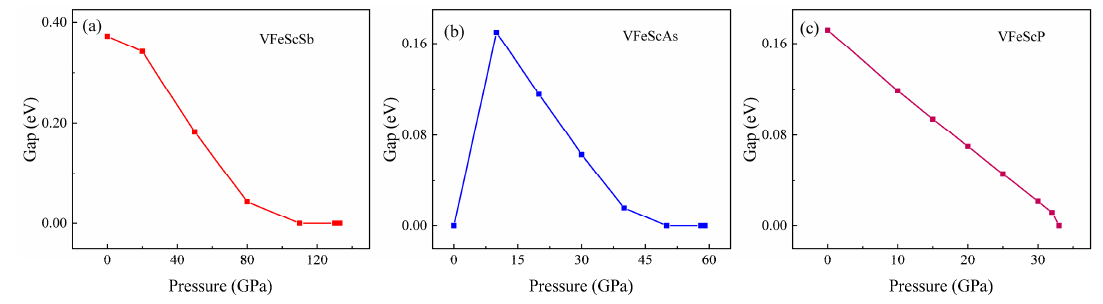
Figure 9. Band gap of type-I ( a ) VFeScSb, ( b ) VFeScAs, and ( c ) VFeScP.